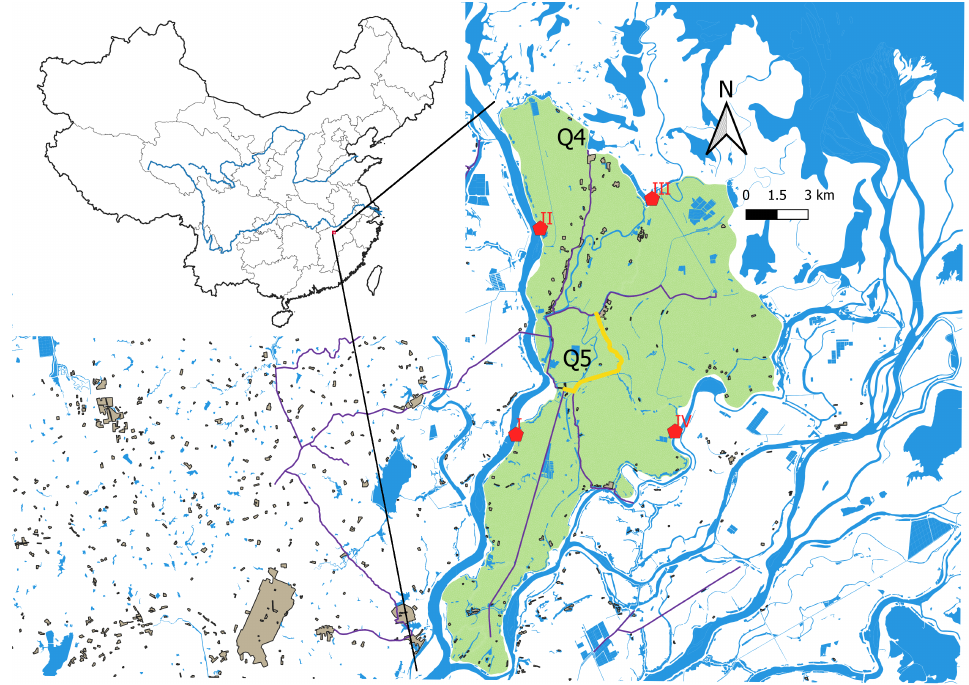
Figure 7. Niansi Levee (green zone), with locations of simulated breach in red